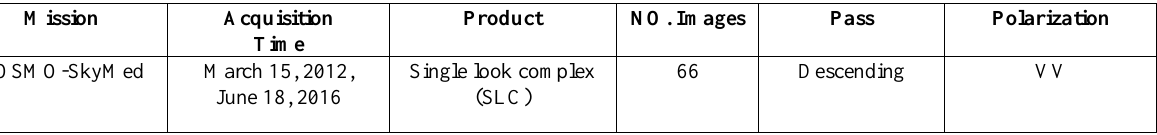
Table 1 . Details of the COSMO-SkyMed acquisitions.